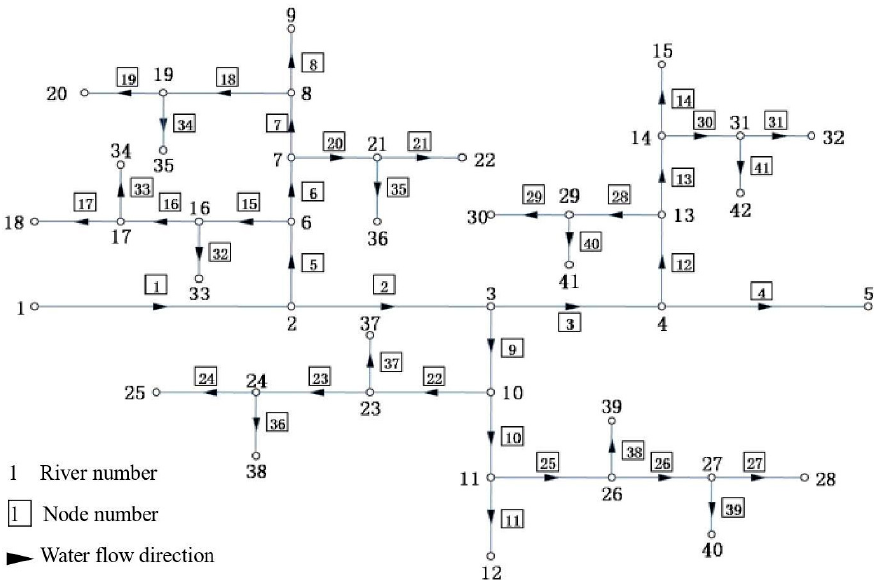
Figure 3. Schematic diagram of the river network structure.